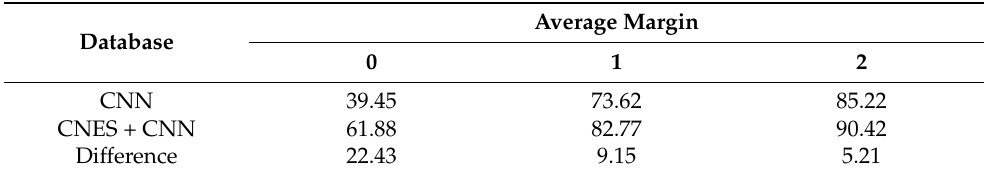
Table 8. Difference of experimental average results